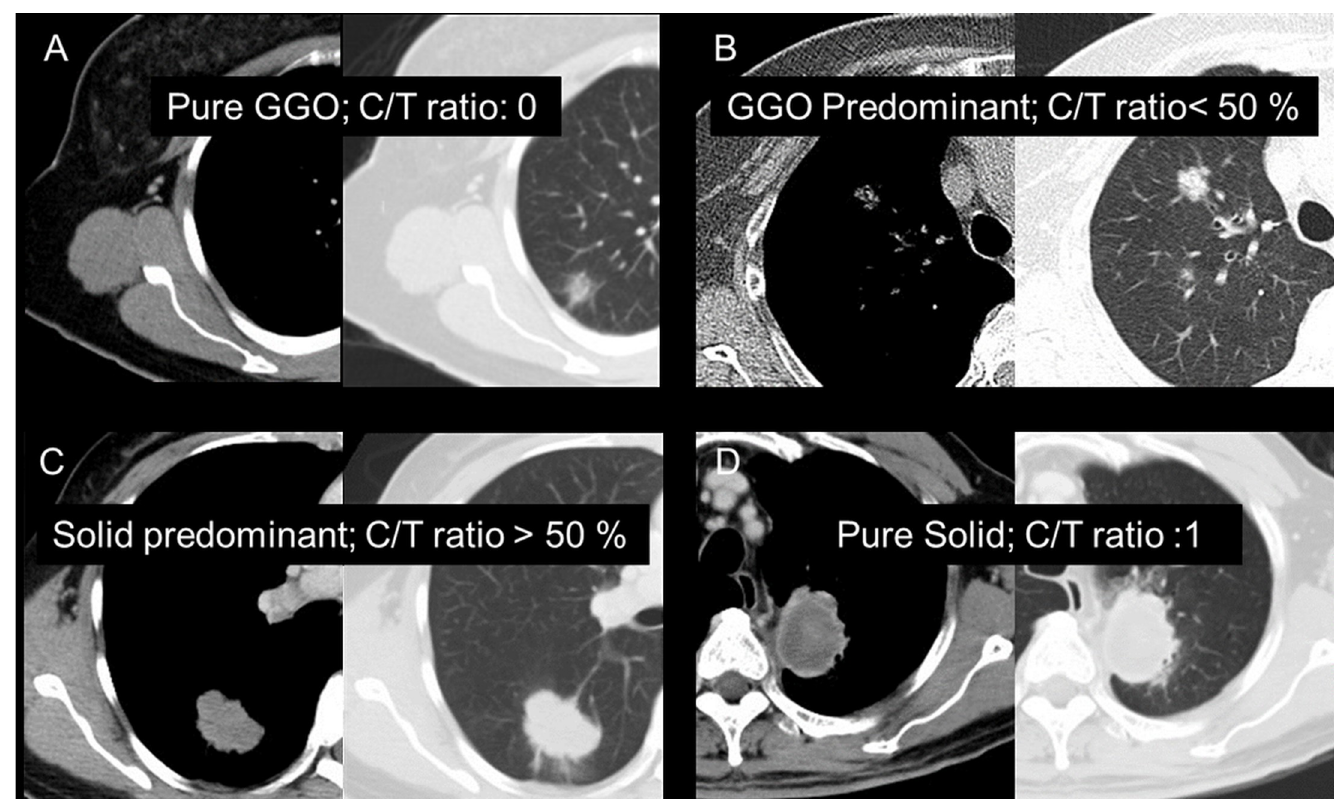
Fig 3. Classifications of tumor component. A. Pure ground glass opacity (GGO) B. Ground glass predominant C. Solid predominant D. Pure solid.